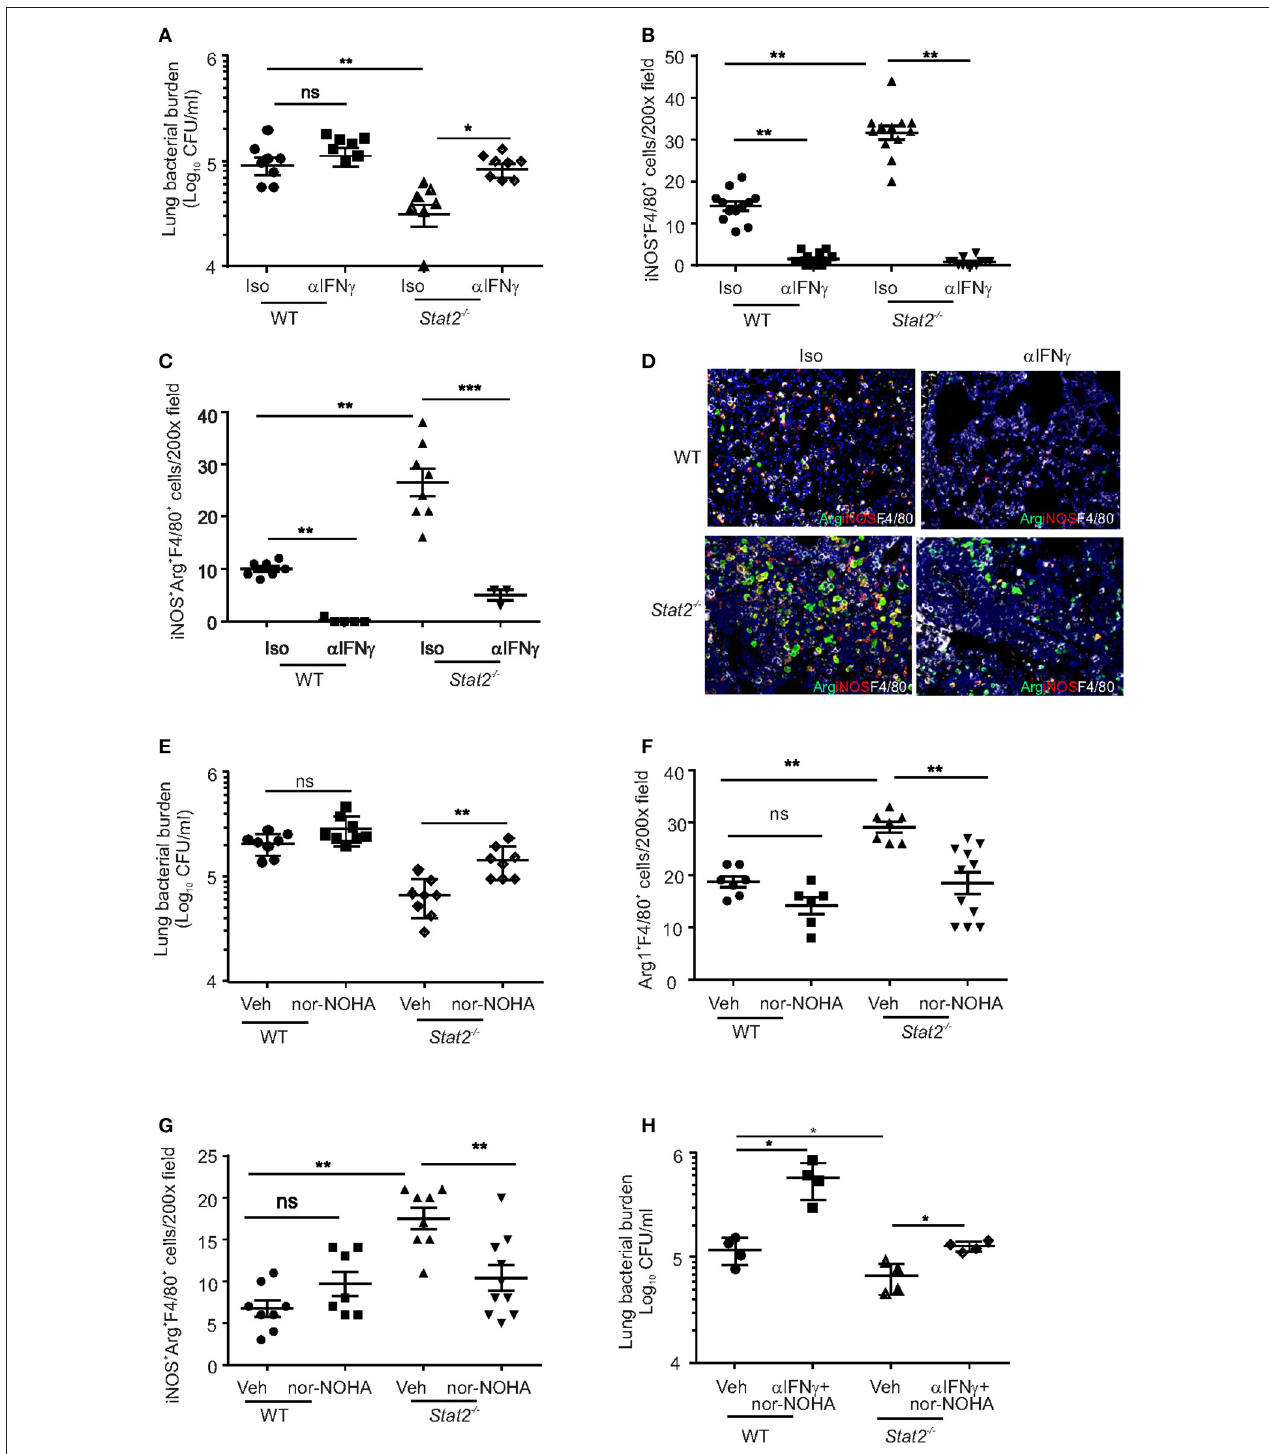
FIGURE 6 | M1/M2 co-expressing macrophages are required for increased bacterial clearance in Stat2 − / − during influenza-MRSA super-infection. WT or Stat2 − / − mice were infected with 100 PFU of influenza for 6 days then challenged with 5 × 10 7 cfu of MRSA for one additional day. Mice were treated with 300 µ g of anti-IFN γ antibodies or 300 µ g of rat IgG isotype controls as described in methods. (A) Bacterial burden was measured, N = 7–8 per group, (B) iNOS + F4/80 + producing cells, N = 12 per group (C) iNOS + Arg1 + F4/80 + producing cells, N = 3–7 per group (D) were determined by IHC, representative figures x200 magnification fields are shown. WT or Stat2 − / − mice were infected with 100 PFU of influenza for 6 days then challenged with 5 × 10 7 cfu of MRSA for one additional day. Mice were